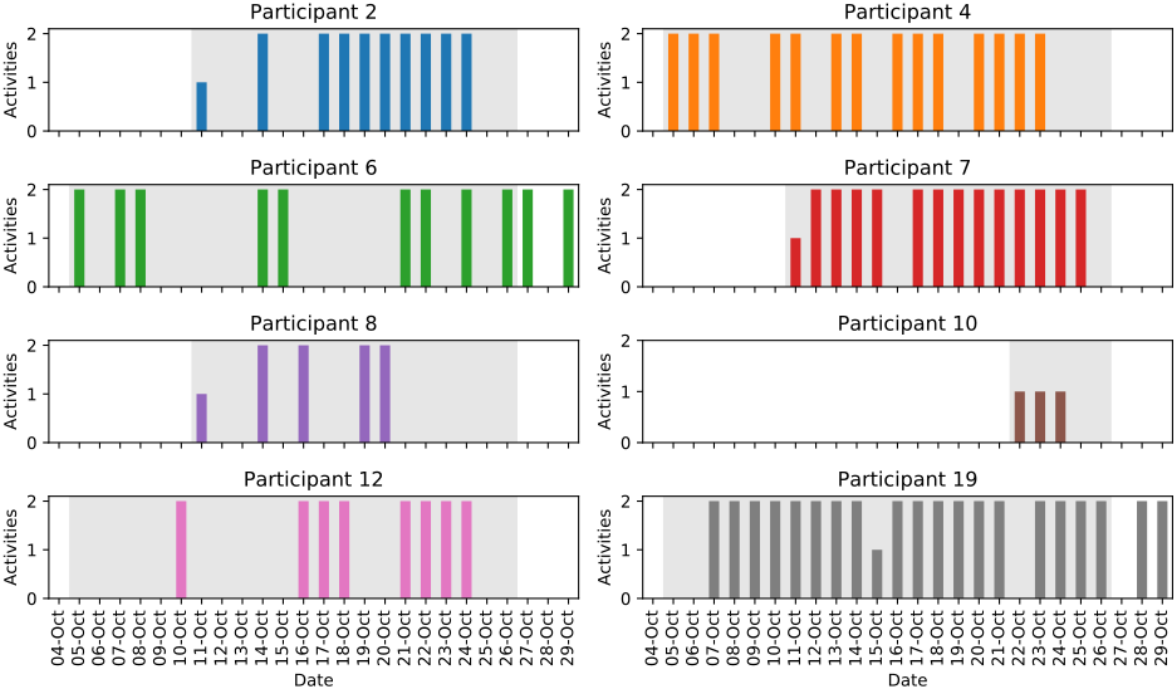
Figure 3. Number of activities recorded per day for each participant in the experiment group. The period where each participant had downloaded the game, but before the test period had concluded, is indicated by the shaded background. One participant was not shown, as they did not use the game after downloading it on their